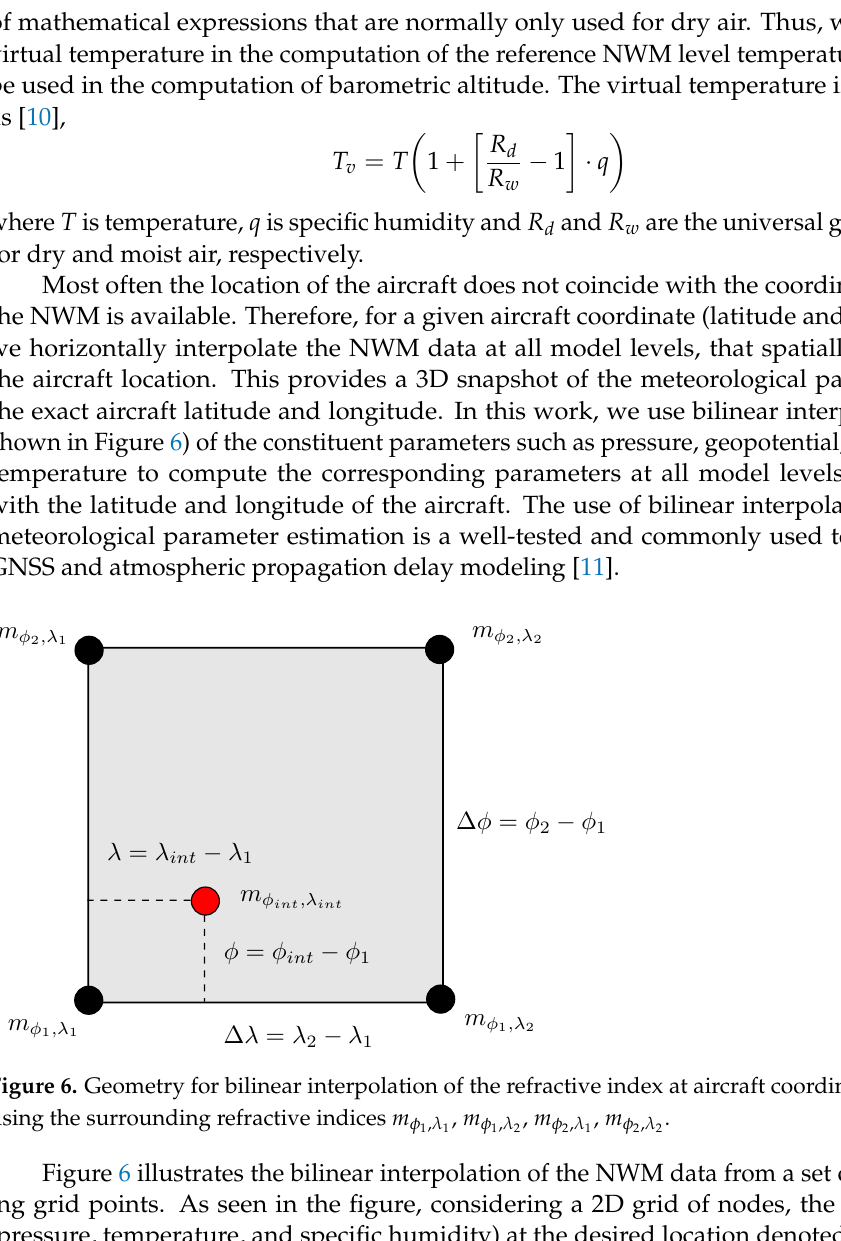
, m φ , m φ , m φ 2 , λ 1 2 , λ 2 1 , λ 1 1 , λ 2